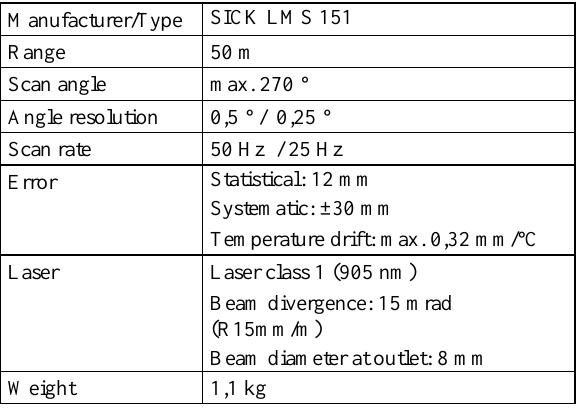
Table 2: Laser scanner technical specifications